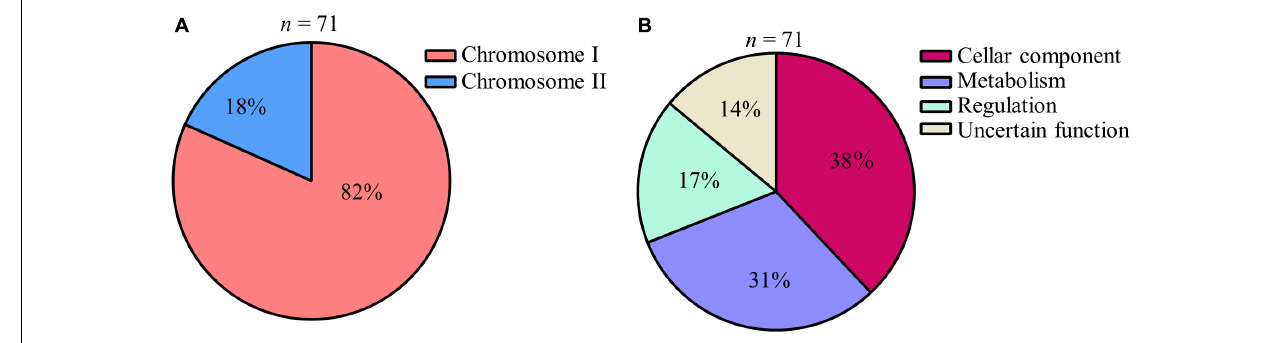
FIGURE 2 | Broad grouping of genes detected by STM screening (A,B) Genes detected by STM were broadly grouped. Pie charts showing their chromosomal localization (A) and their predicted function (B) .